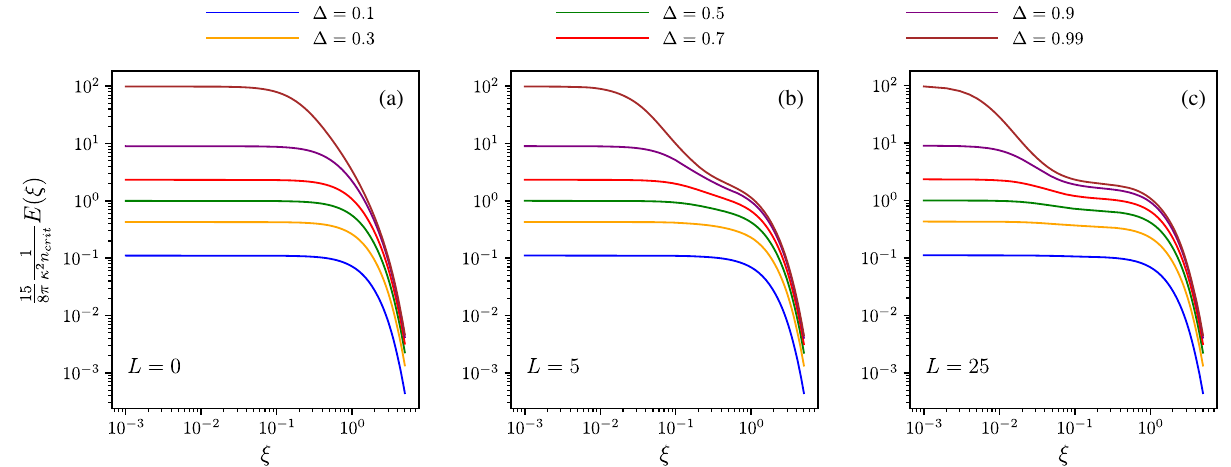
FIG. 4. The fluid velocity energy spectra E ð ξ Þ [Eq. (71)] as a function of the dimensionless wave number ξ for various values of Δ . (a) L ¼ 0 , (b) L ¼ 5 , and (c) L ¼ 25 . The legend applies to all